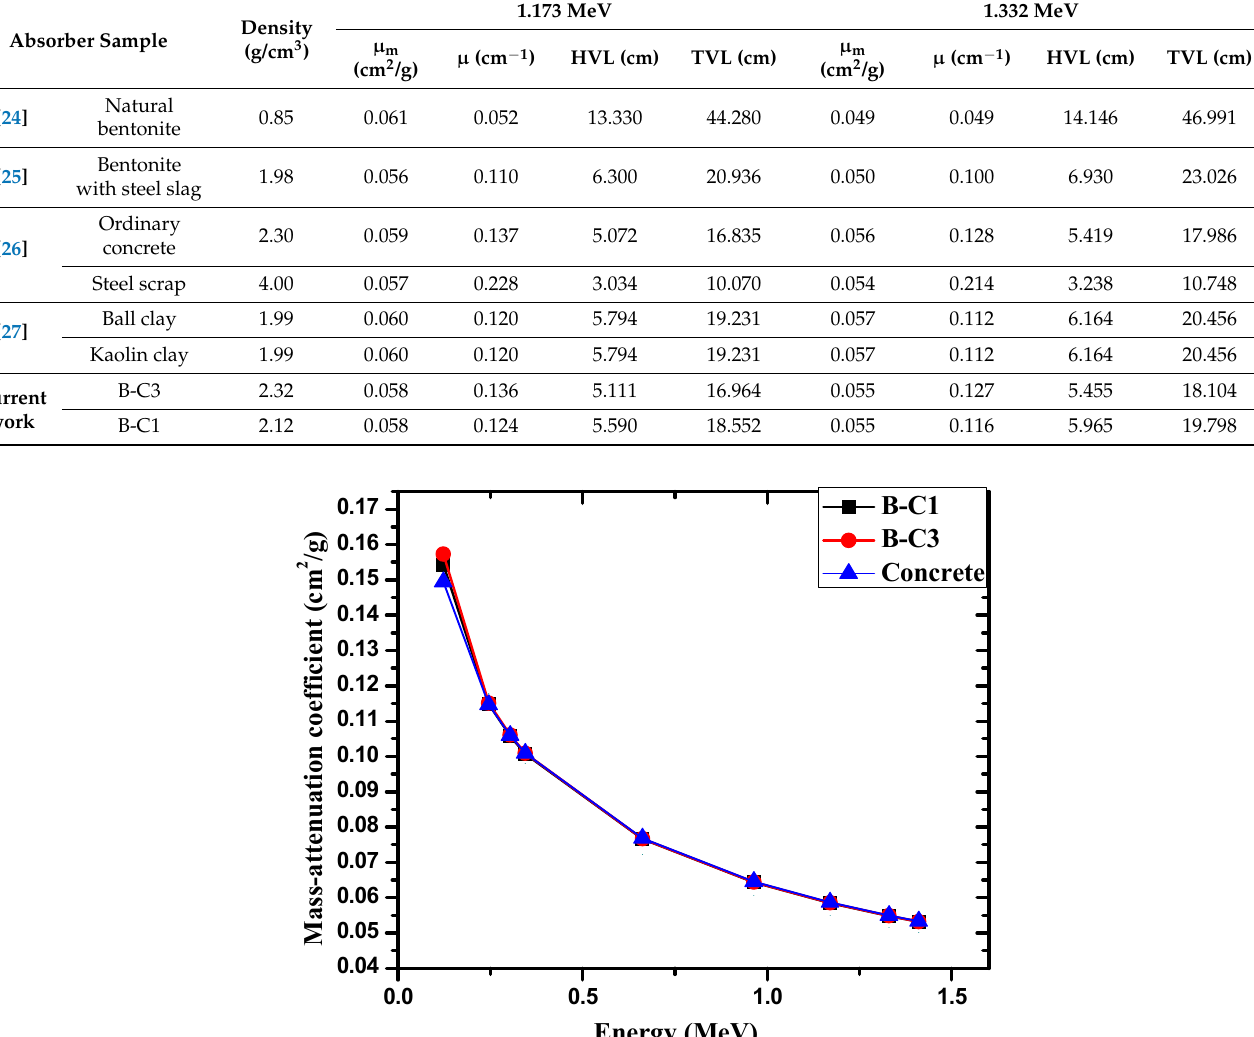
Table 4. Comparison of the shielding ability of the present samples against different studied materials.